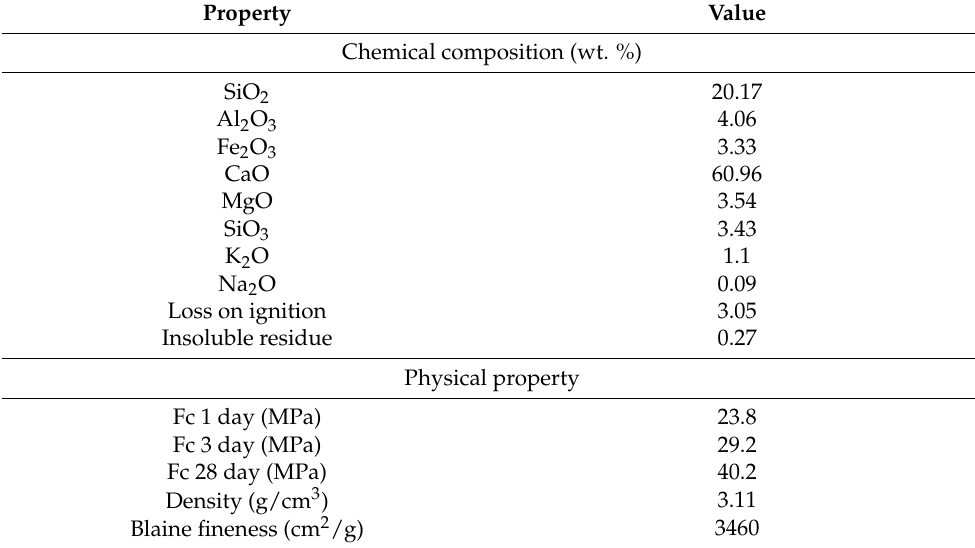
Table 1. Chemical and physical characteristics of the Portland cement used. Property